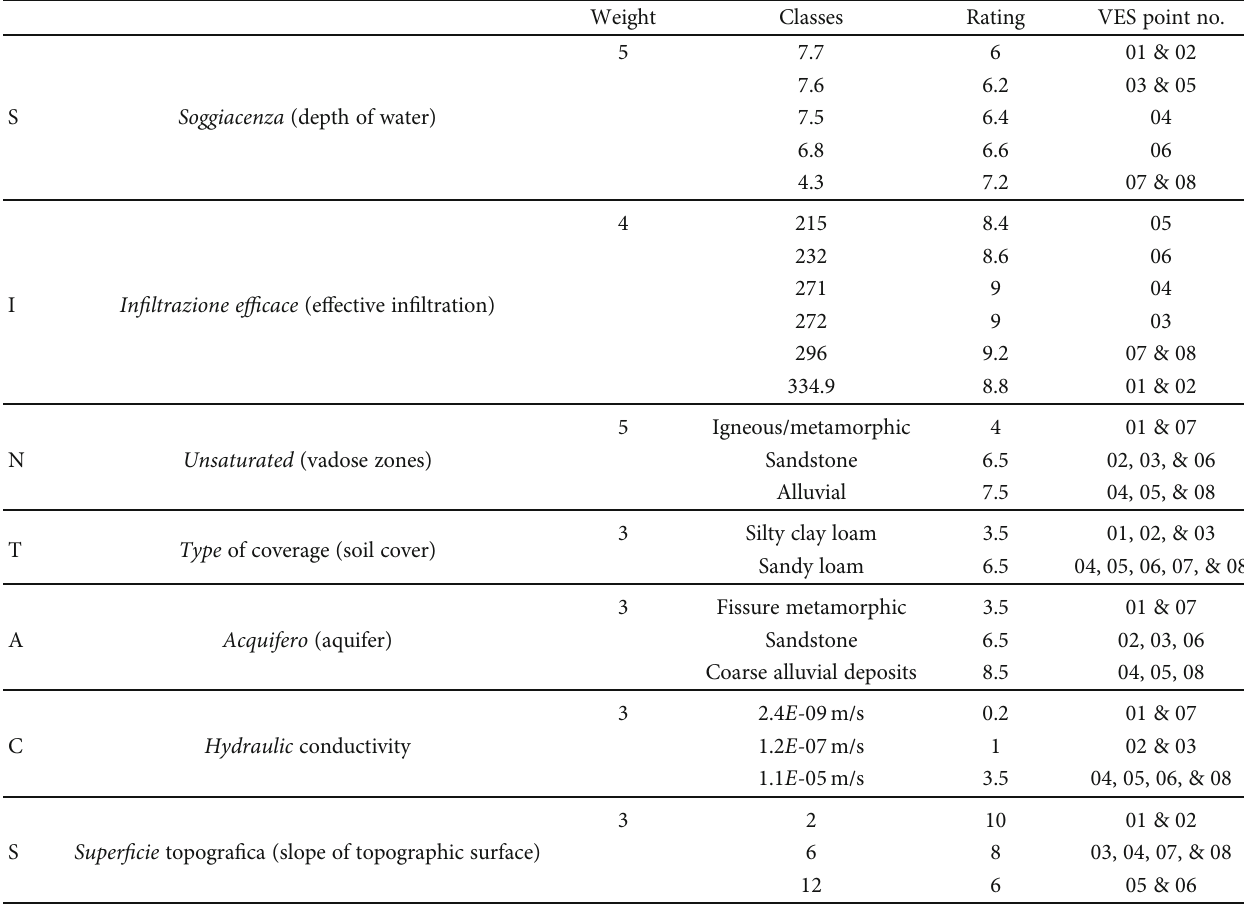
Table 10: Resume SINTACS